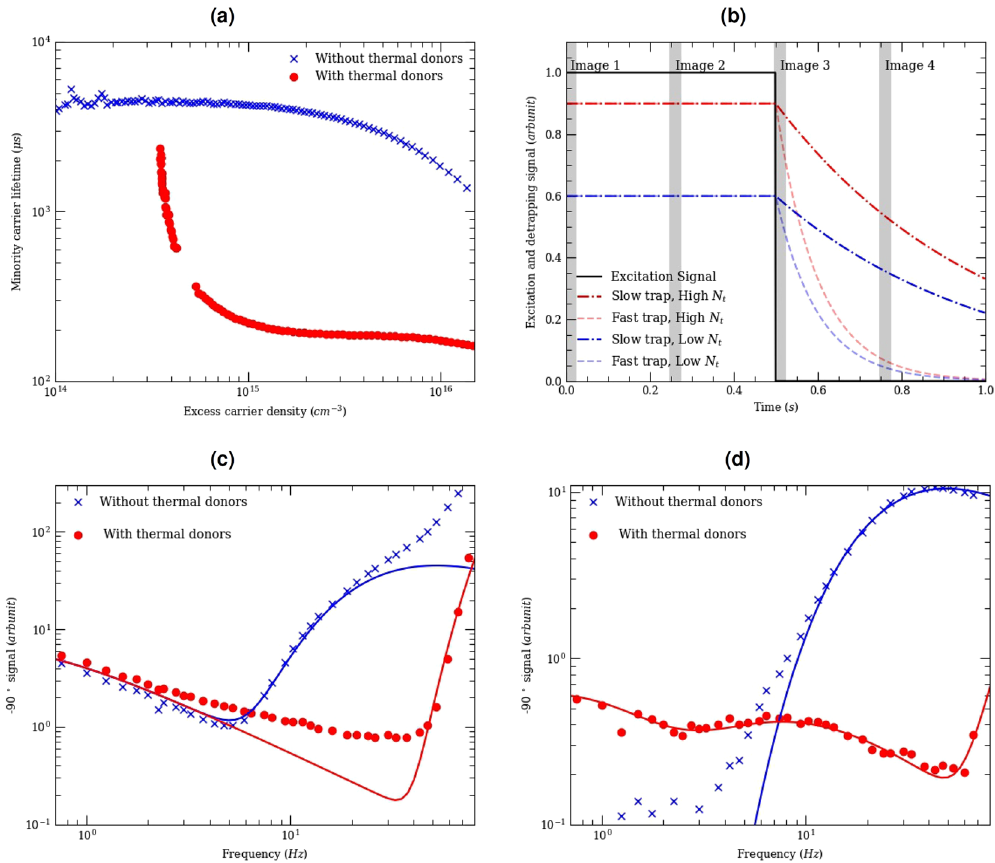
Figure 1. ( a ) Injection dependent lifetime as measured using Quasi-Steady-State PhotoConductance (QSSPC) showing steady-state trapping. ( b ) Principle of the lock-in system showing a range of detraping transients with different trap concentrations and time-constants during a single lock-in period. Frequency dependent lock-in free carrier emission signal measured under ( c ) high excitation power (9.1 − 2 W . cm − 2 ) and ( d ) low excitation power (7.9 × 10 − 6 W . cm − 2 ). The lines are fits with four parameters: a single value for the effective lifetime, the initial carrier density, a single value for the detraping time constant, the trap